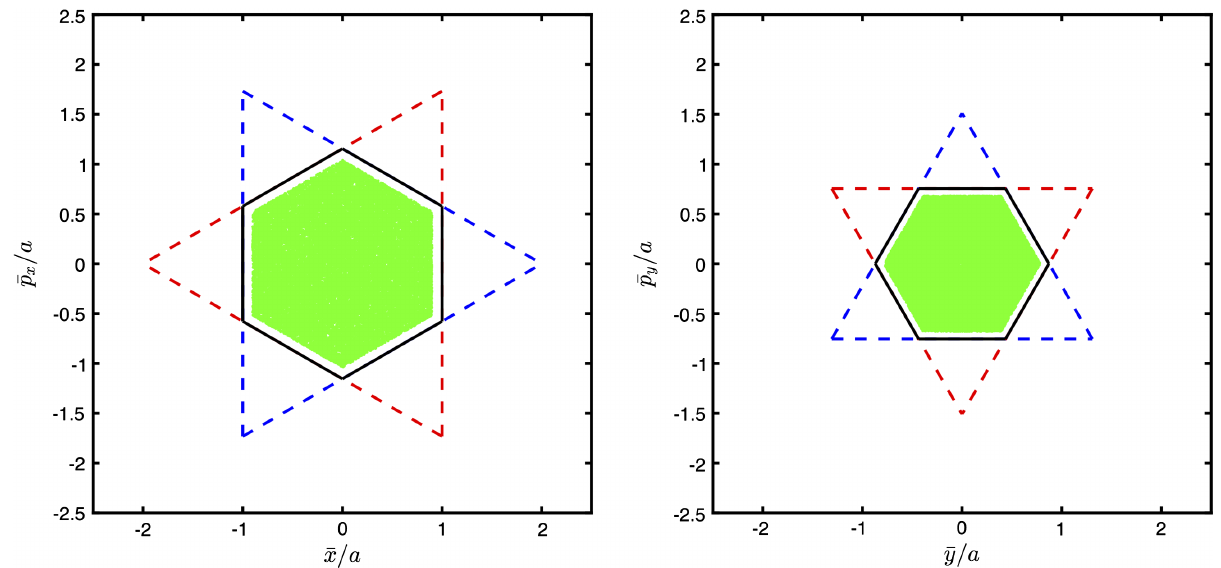
FIG. 13. Hexagons: the region of stability in the 4D phase spaces near 1 = 3 resonance with a deviation of Δ ν ¼ 0 . 005